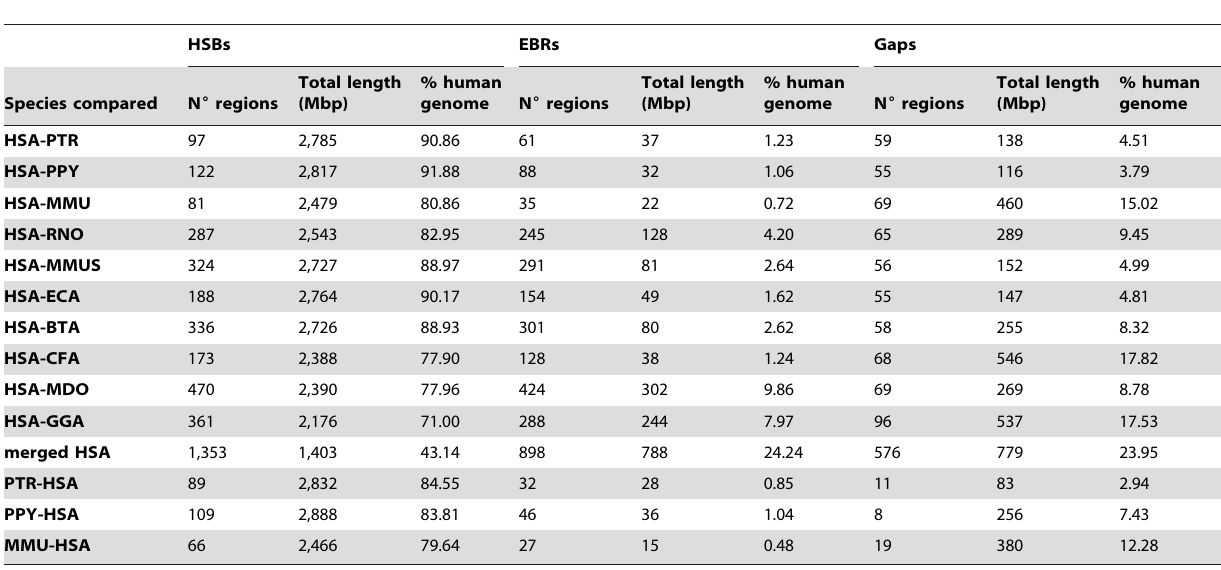
Table 1. Homologous synteny blocks (HSBs) and evolutionary breakpoint regions (EBRs) in primate genomes.